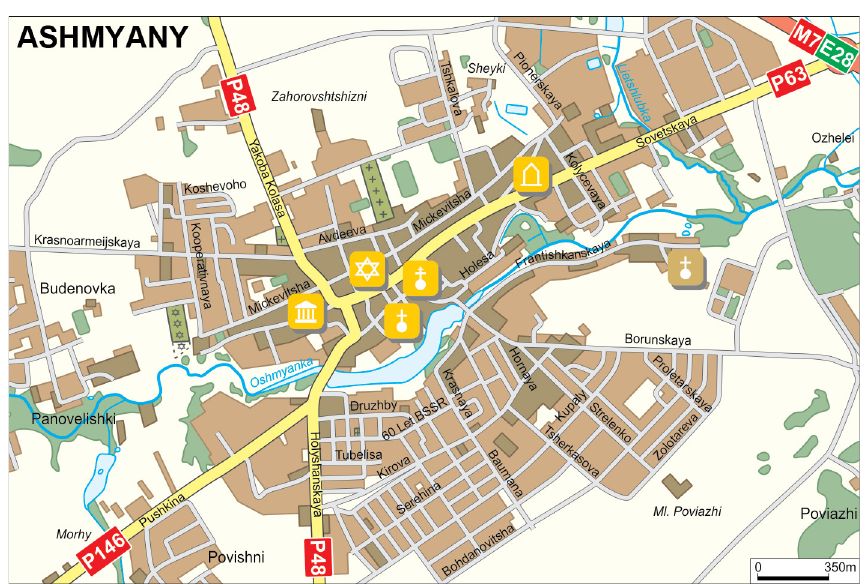
Fig. 1. Ashmyany (Belarus) 1:35,000 – town map designed for the Shtetl Routes guidebook